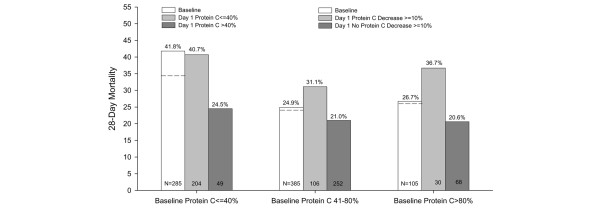
PROWESS 28-day placebo mortality rates: effect of baseline protein C class. Placebo patient baseline and day 1 protein C levels were assessed and patient outcomes at 28 days determined. Twenty eight-day mortalities, based on baseline protein C and day 1 protein C levels are presented. Mortality of severely deficient patients at baseline increased if protein C levels remained ≤ 40% and decreased if protein C levels increased to >40%. Mortality of deficient (41–80%) and normal (>80%) patients increased if there was a ≥ 10% drop in protein C levels and decreased if there was no drop ≥ 10%. The area/% above the dashed lines in all baseline bar graphs represent patients that died before a day 1 protein C measurement was performed.